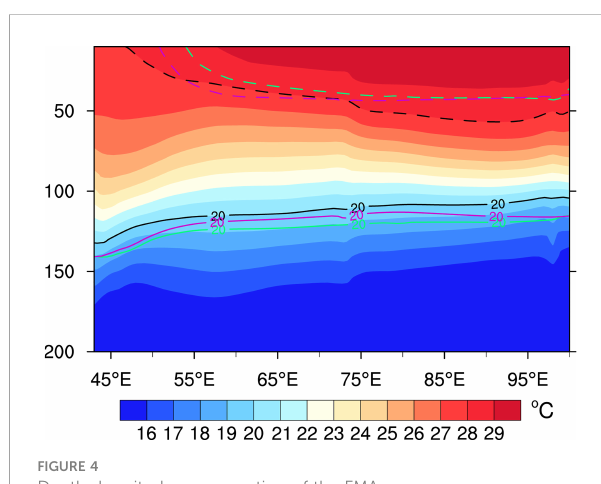
FIGURE 4 Depth – longitude cross-section of the FMA mean ocean temperature (shading; units: °C) along the EIO averaged between 2° S – 2° N in the observations. The 20°C (28°C) isotherms in the observations, the CMIP5 MME, and the CMIP6 MME are marked by the black, green, and purple solid (dashed) curves,